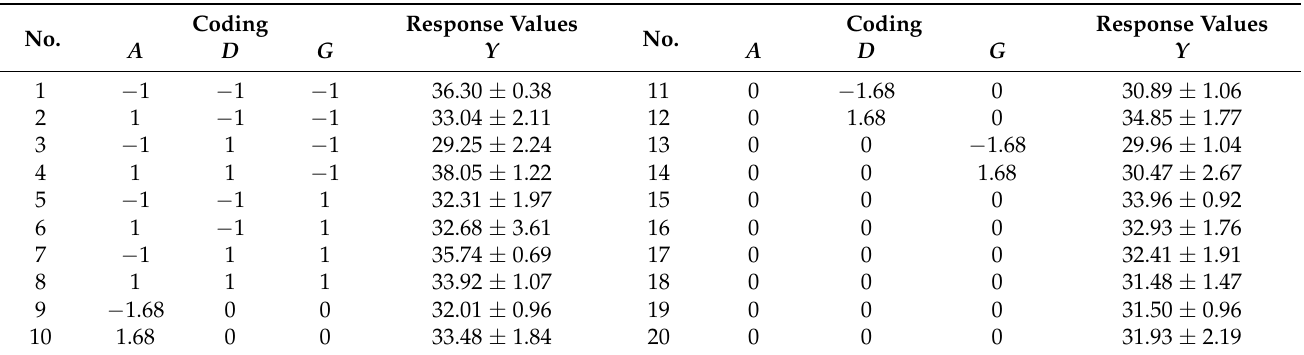
Table 7. The experimental schemes and the results of the significant influencing factors (the Poisson’s ratio of FJF A , the static friction coefficient of FJF–FJF D , and the static friction coefficient of FJF–steel plate G ) with the central composite design.